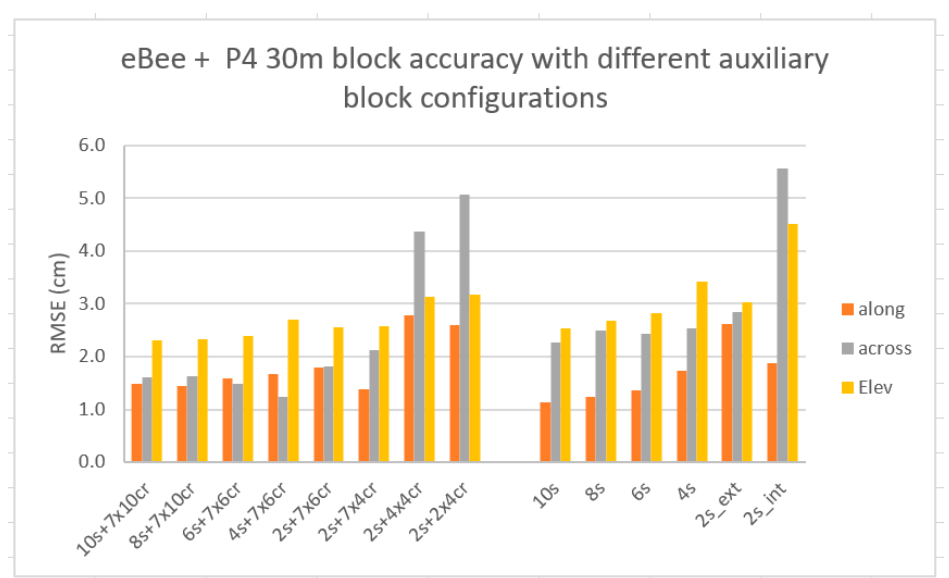
Figure 7. Effect on CP accuracy of the progressive removal of longitudinal and cross strips from the eBee flights in the joint adjustment with the P4 30 strip. RMSE of the coordinates at 44 CP: along bridge direction (red), across bridge direction (grey) and elevation (orange).